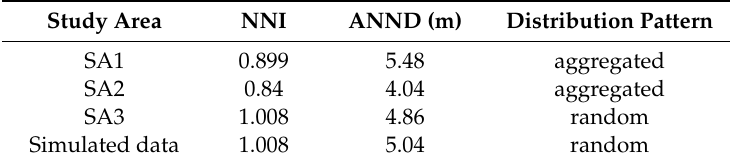
Table 3. Spatial distribution pattern of sampling points in study areas 1–3 and simulated